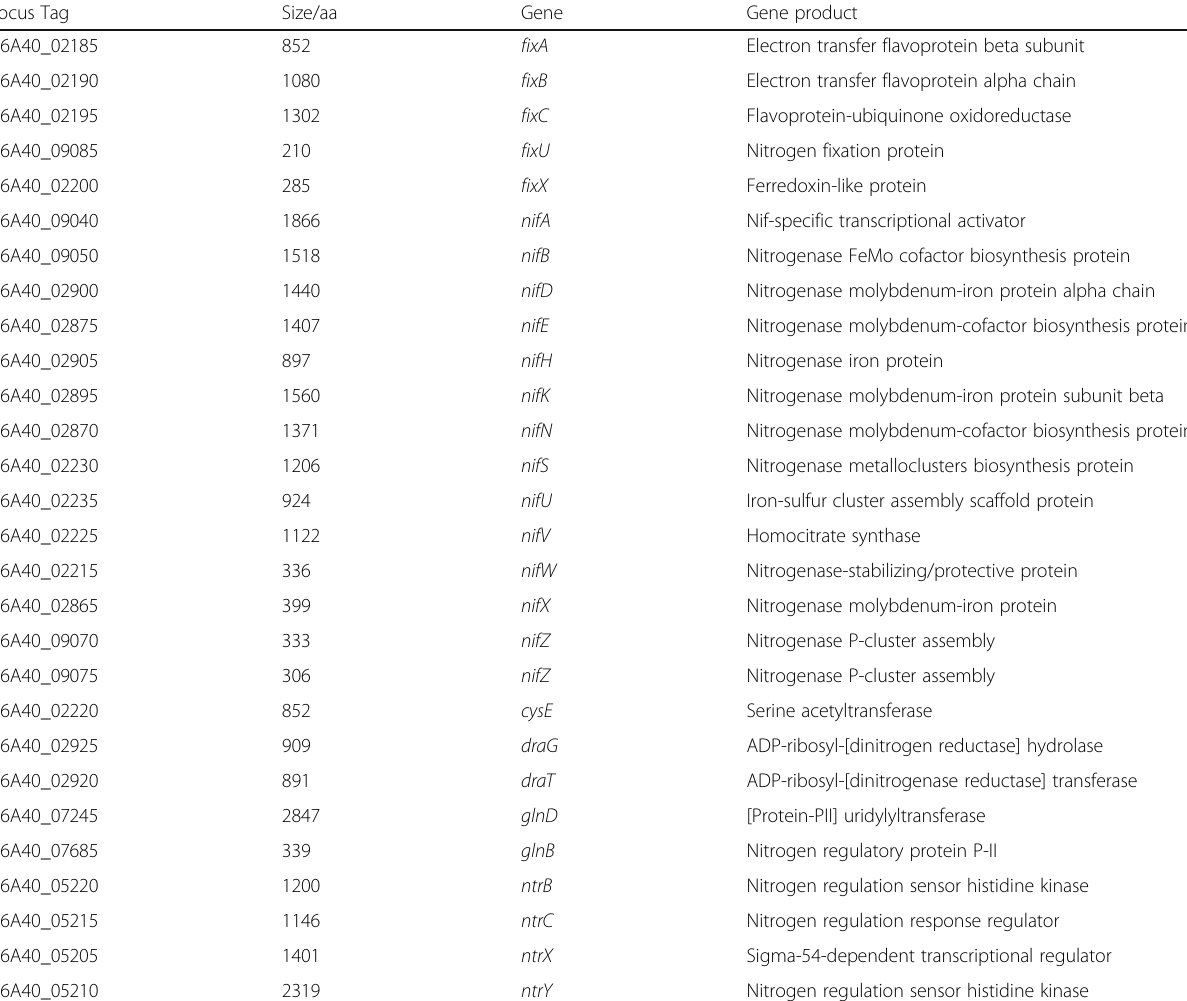
Table 7 Genes of A. humicireducens SgZ-5 T involved in nitrogen fixation Locus Tag